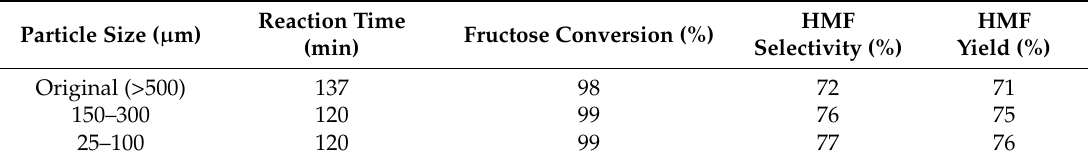
Table 2. Effect of catalyst particle size on fructose conversion, HMF selectivity and HMF yield.